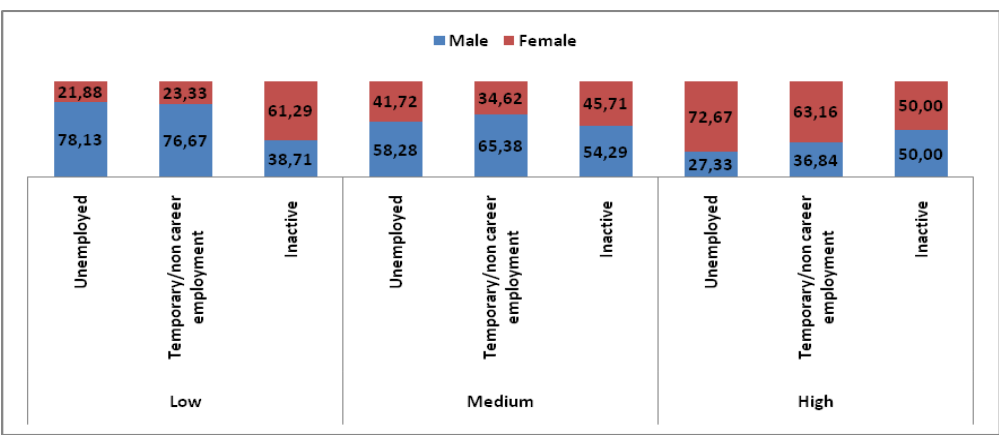
Figure 12: Characteristics of youth in transition by gender and education level (%)